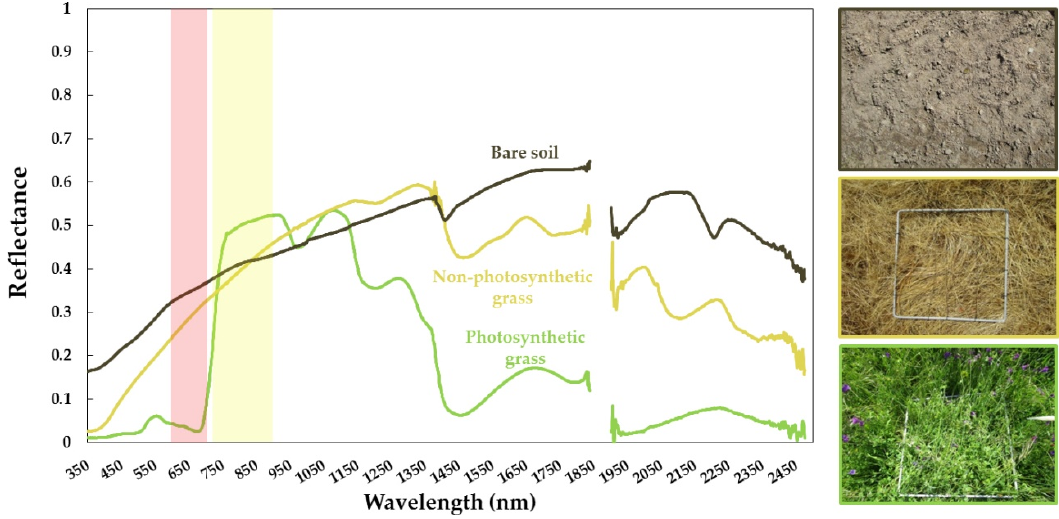
Figure 3. The spectral response measured with the spectroradiometer of bare soil, along with images of photosynthetic and non-photosynthetic grass under full vegetation conditions.